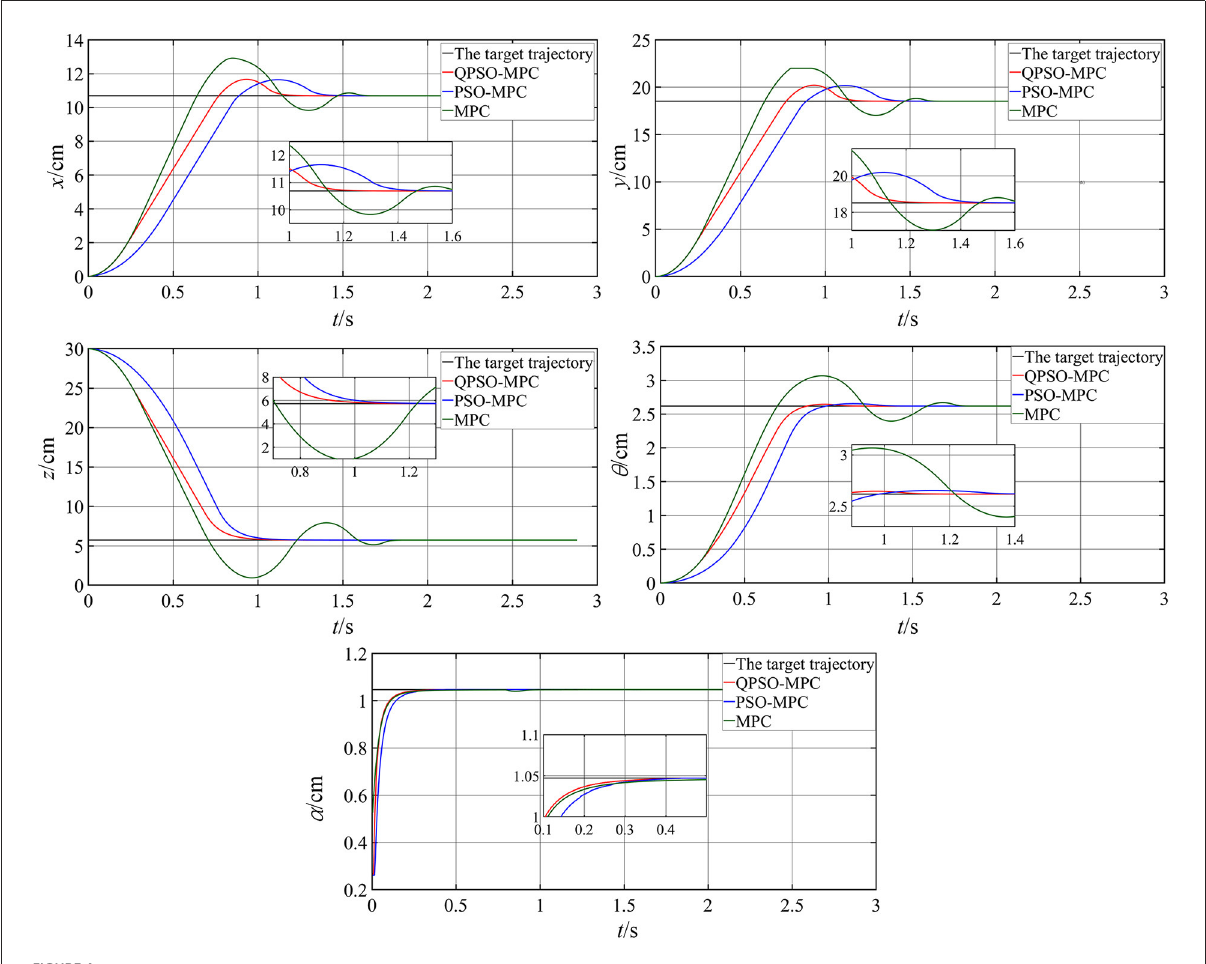
FIGURE4 Simulation results of setpoint